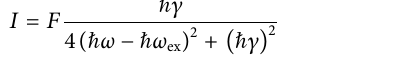
Frontiers in Materials |